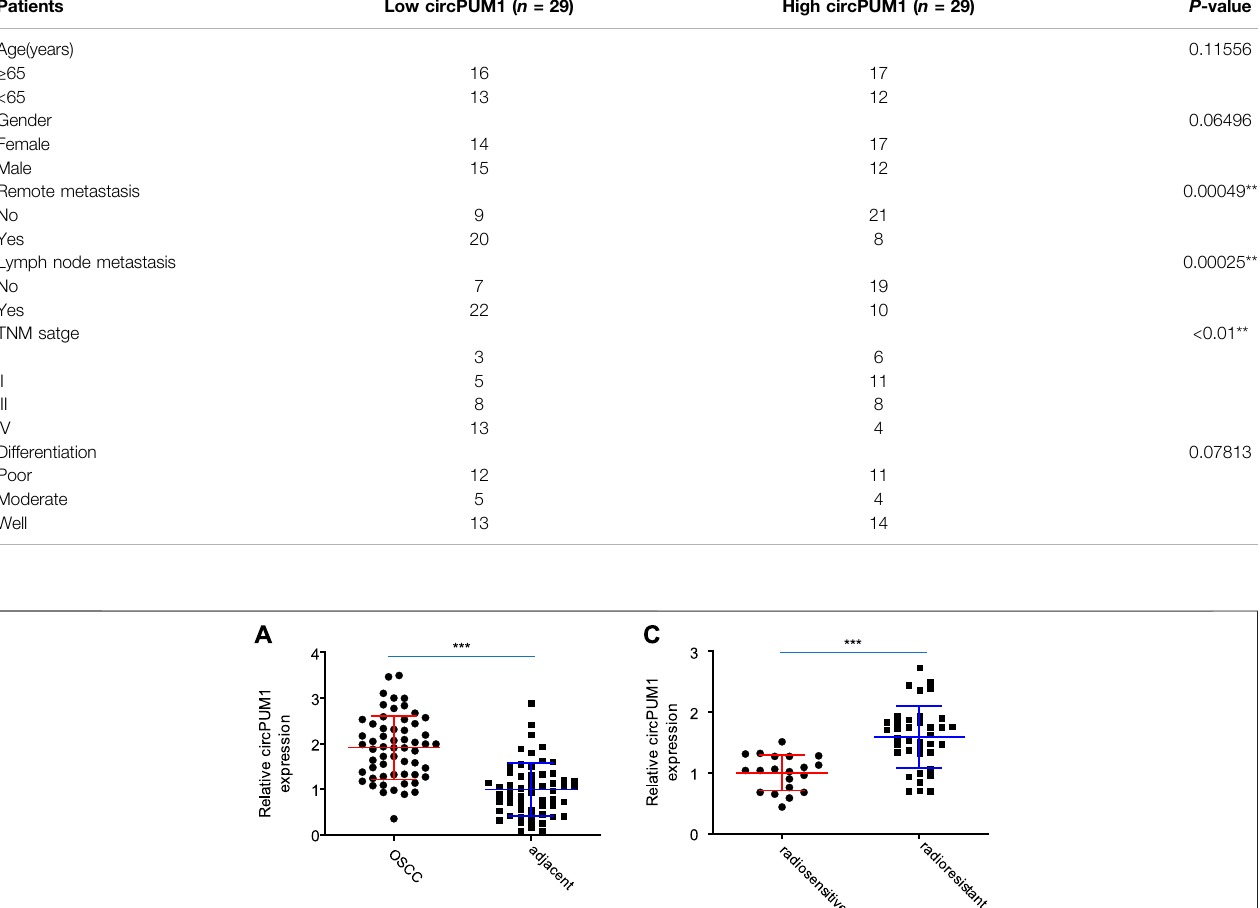
TABLE 1 | Patient information and clinicopathological characteristics of 58 patients with OSCC *P < 0.05 or **P < 0.01 was considered signi fi cant (chi-square test between 2 groups). Patients